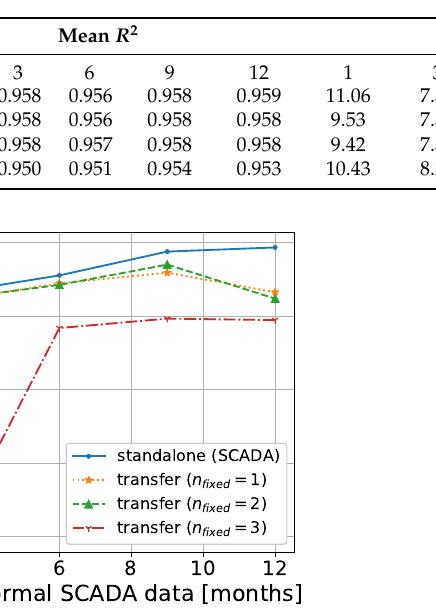
Figure 13. R 2 value for ANN for different amounts of training data and knowledge transfers tested on same 3 months test